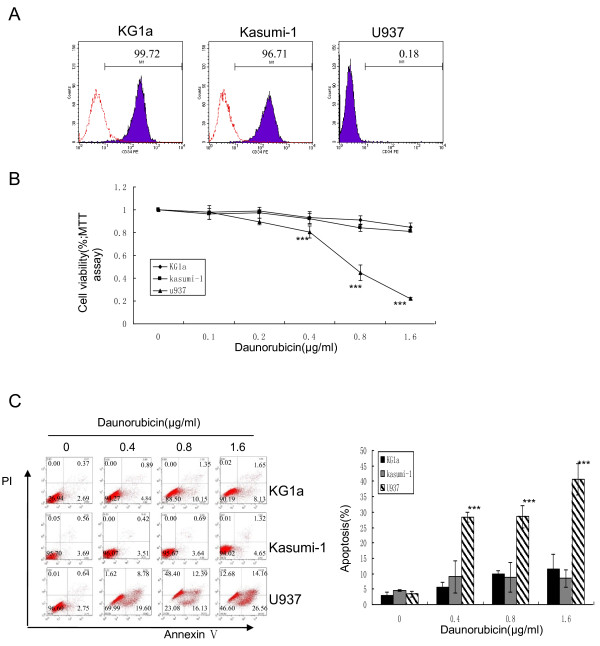
CD34+ KG1a and Kasumi-1cells were insensitive to DNR. (A) KG1a, Kasumi-1 and U937 cells were stained with PE-conjugated CD34 antibody and subjected to flow cytometry to determine the purity of CD34+ cells. (B, C) These three cell lines were treated with different concentrations of DNR for 48 h. MTT assay (B) was performed as described in "Methods" and apoptosis (C) was assessed by Annexin V/PI assays. Cells in the lower right quadrant represent early apoptosis and those in the upper right quadrant represent late apoptosis. The graph displays the means ± SD of three independent experiments. * p < 0.05, ** p < 0.01, *** p < 0.001 (compared with control).